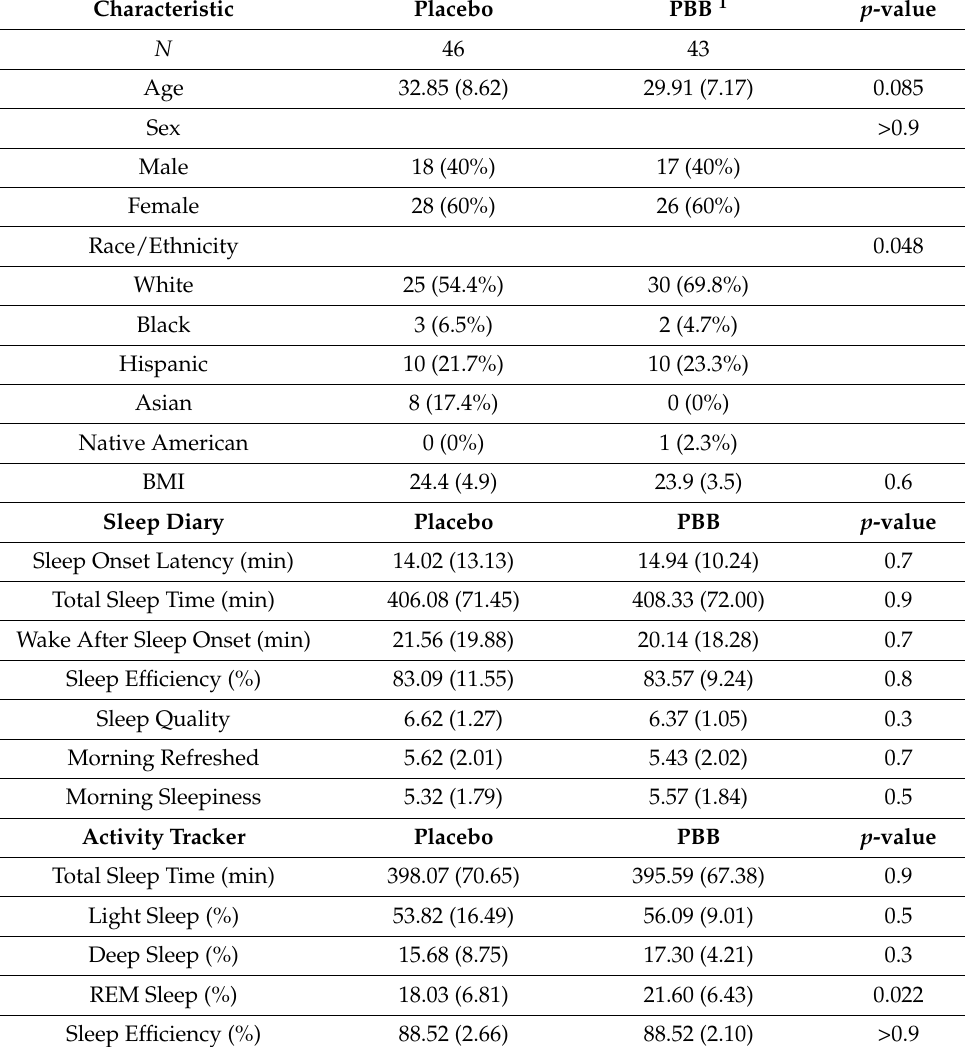
Table 1. Baseline characteristics for the